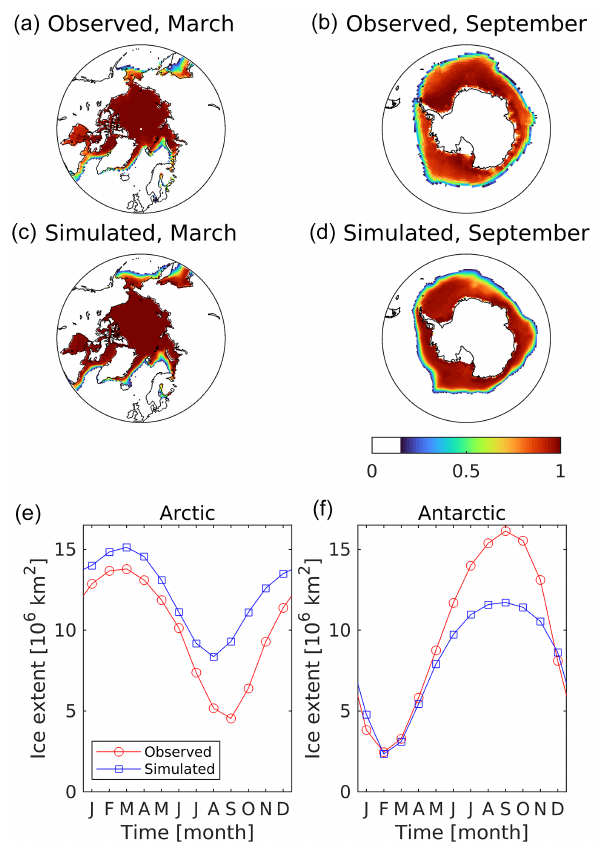
Figure 2. Observational ( a, b ; HadISST) and simulated (c, d) maxi- mum annual sea ice cover for the Arctic (March; a, c, e ) and Antarc- tic (September; b, d, f ). Sea ice cover is non-dimensional, and val- ues less than 0.15 have been masked. The bottom row shows the seasonal sea ice extent ( > 15% cover; in 10 6 km 2 ) for the polar regions of each